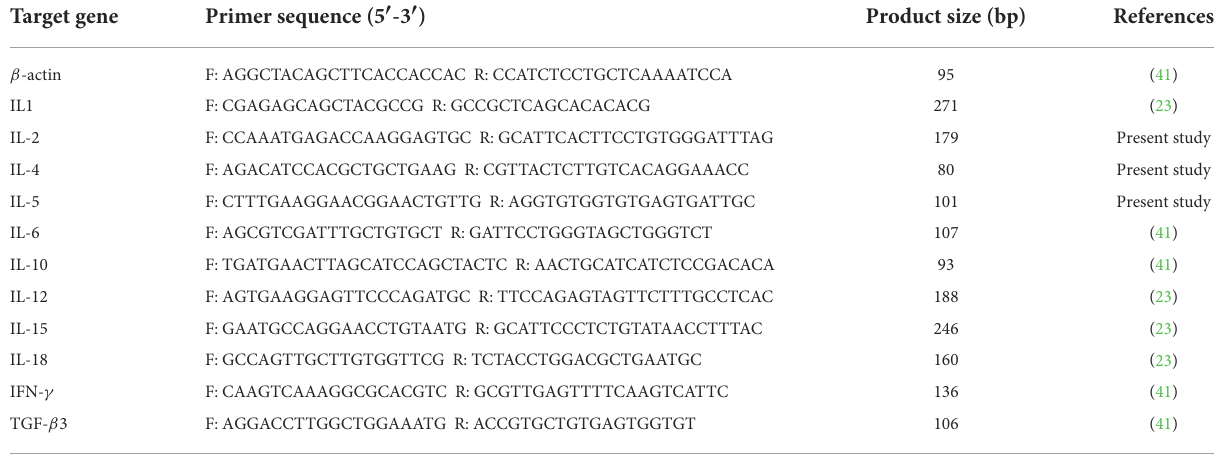
TABLE 1 Primers used for evaluating the effect of P. vivax infection on cytokines expression in P. vivax -infected pigeons by the quantitative real-time PCR. Target gene